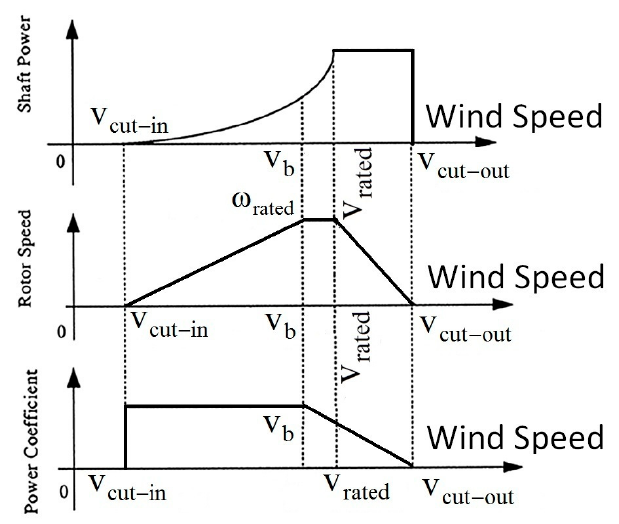
Figure 3. Operation regions of the VWT.